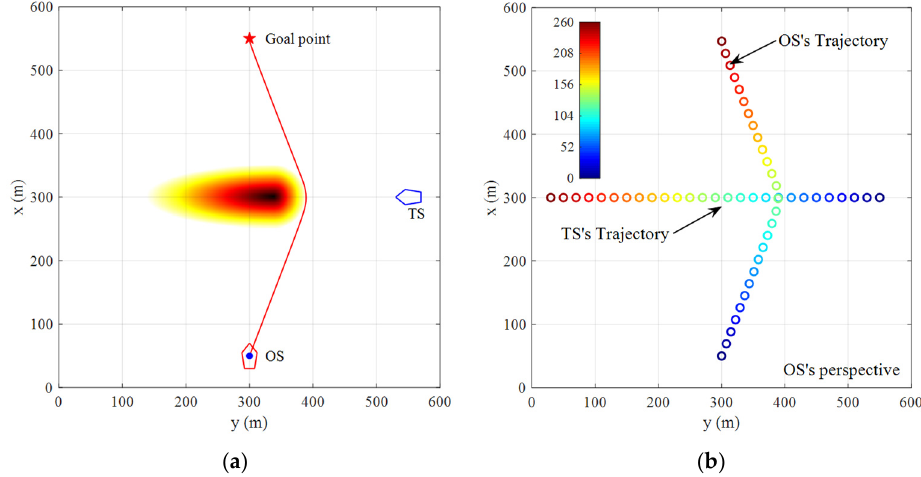
Figure 10. The path planning results and the collision avoidance trajectories in Crossing − 2. ( a ) The path planning results, ( b ) The collision avoidance trajectories.